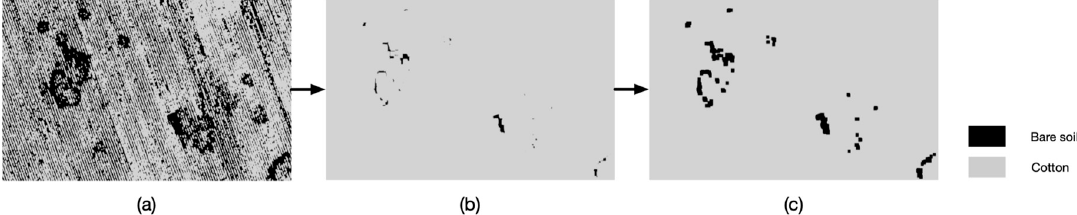
Figure 15. The strip-shaped bare soil pixels were effectively removed using morphological closing transformation at northeast of CH field. The ( a ) k-means classification was applied (Scale 1:2000) ( b ) dilation of healthy cotton class followed by ( c) erosion of healthy cotton class.